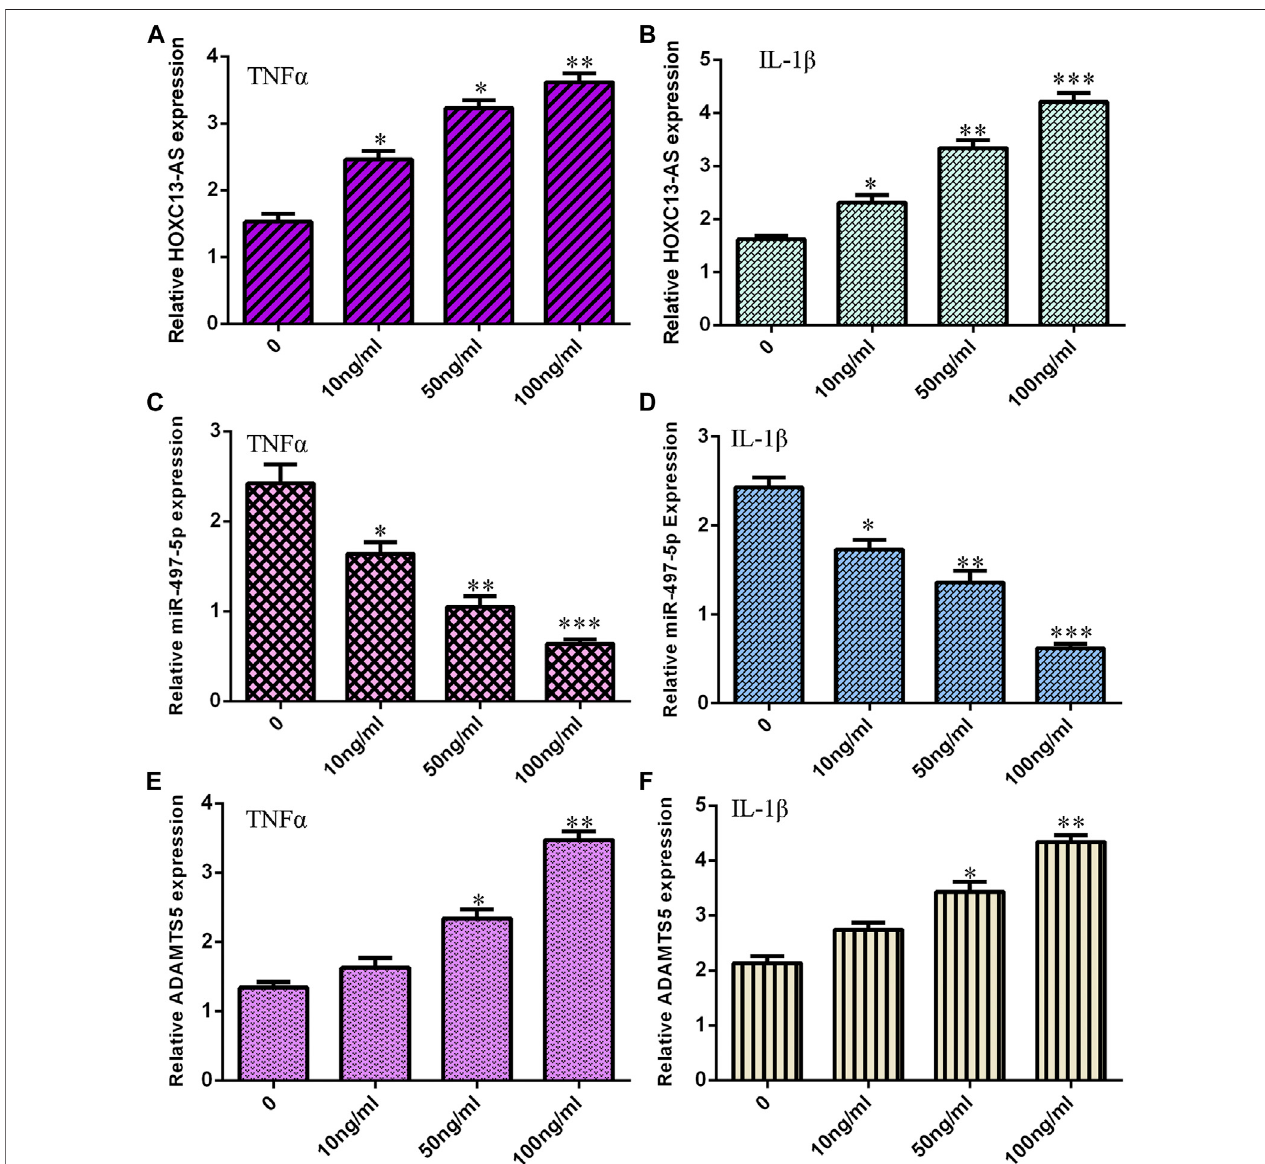
FIGURE 1 | TNF- α and IL-1 β induced HOXC13-AS and ADAMTS5 expression and suppressed miR-497-5p expression. (A) TNF- α induced HOXC13-AS expression in a dose-dependent manner in NP cells. (B) HOXC13-AS expression was measured by qRT-PCR. (C) miR-497-5p expression was decreased in NP cells treated with TNF- α . (D) miR-497-5p expression was detected by qRT-PCR. (E) TNF- α treatment increased ADAMTS5 expression in a dose-dependent manner in NP cells. (F) ADAMTS5 expression was determined by qRT-PCR. * p < 0.05, ** p < 0.01, and *** p < 0.001.